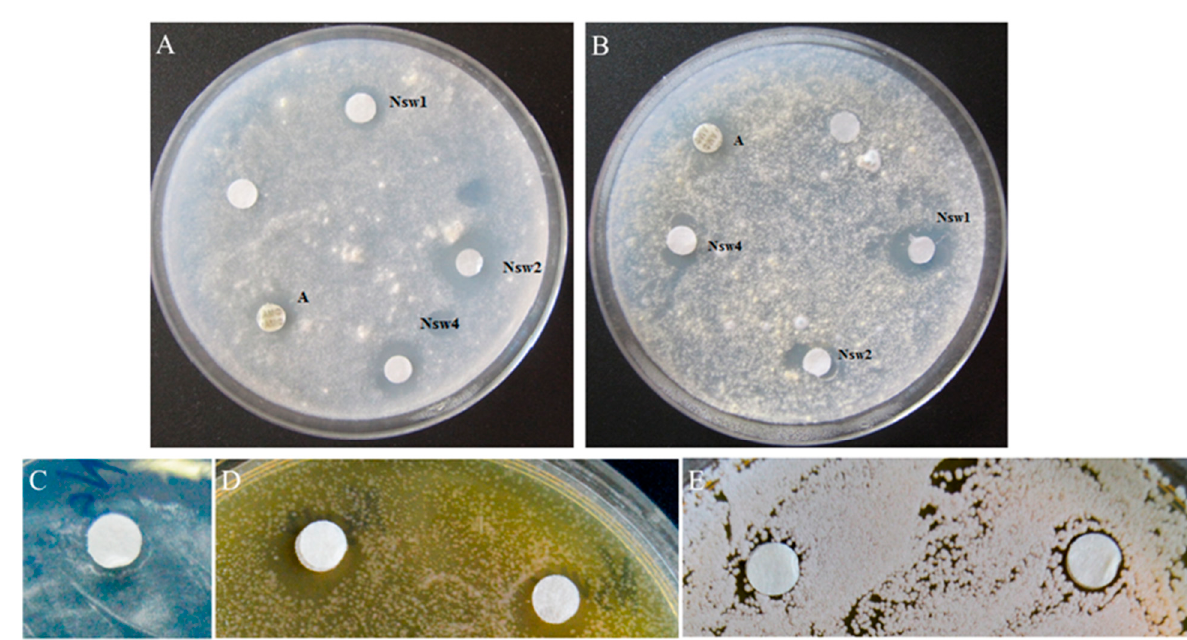
Figure 3. Antimicrobial activity of the N. sativa thionins (NsW1, NsW2 and NsW4) detected by disc-diffusion method: A. fumigatus 2K ( A ) and A. flavus 3K ( B ); Amphotericin B was used as positive control. Inhibition caused by NsW2: A. fumigatus 163m ( C ), Cryptococcus laurentii 801M ( D ) and Candida krusei 1447N ( E ); Nystatin and Fluconazole were used as positive control (not shown on photo).